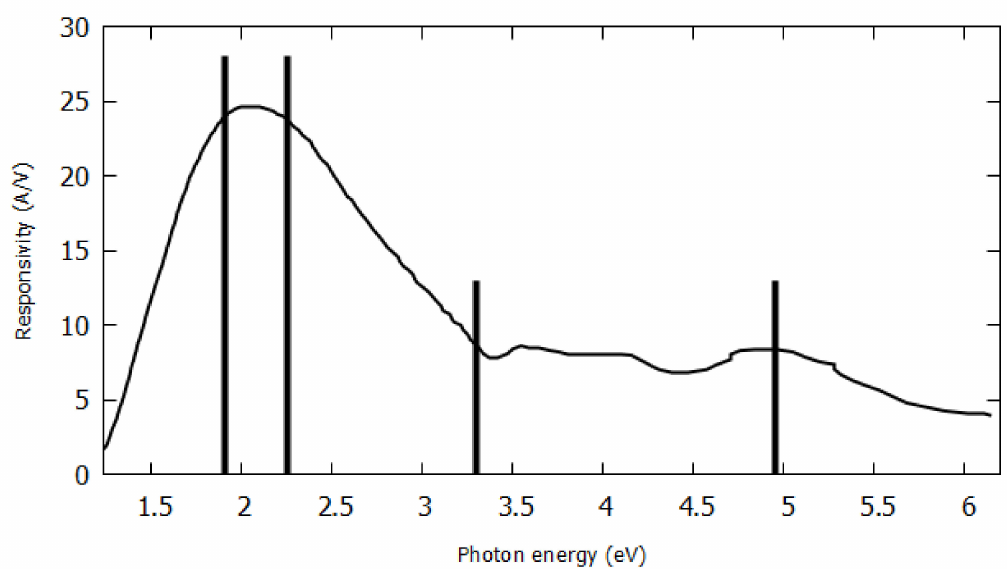
Figure 4. Sensitivity curve of avalanche photodiode. Four vertical lines separates the five energetic regions to control our feedback